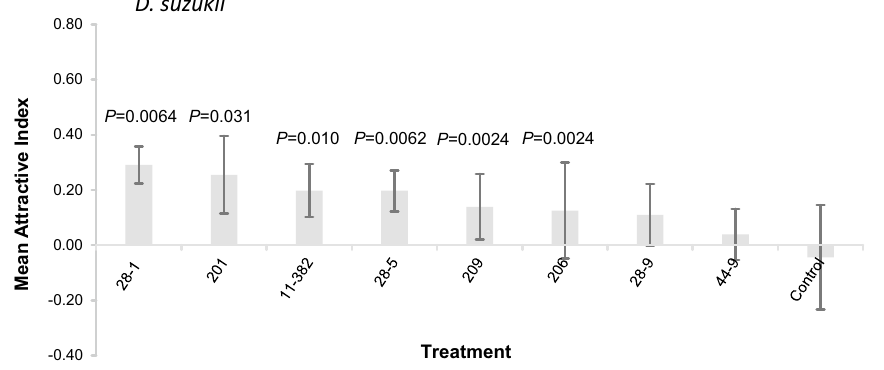
Figure 2. Mean (± SE) Attraction Index (AI) of D. suzukii to metabolic volatiles (not identified) from eight Hanseniaspora uvarum isolates grown in sterile strawberry juice using laboratory T-mazes; control contains no yeast (N = 8, except 28–1 and control, N = 7). P-values above bars show significance of attraction to yeast volatiles over sterile strawberry juice in the opposing T-maze arm revealed by binomial